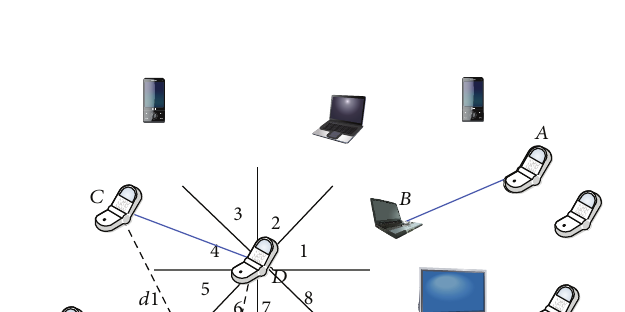
Figure 2: Intergroup multihop scenario.